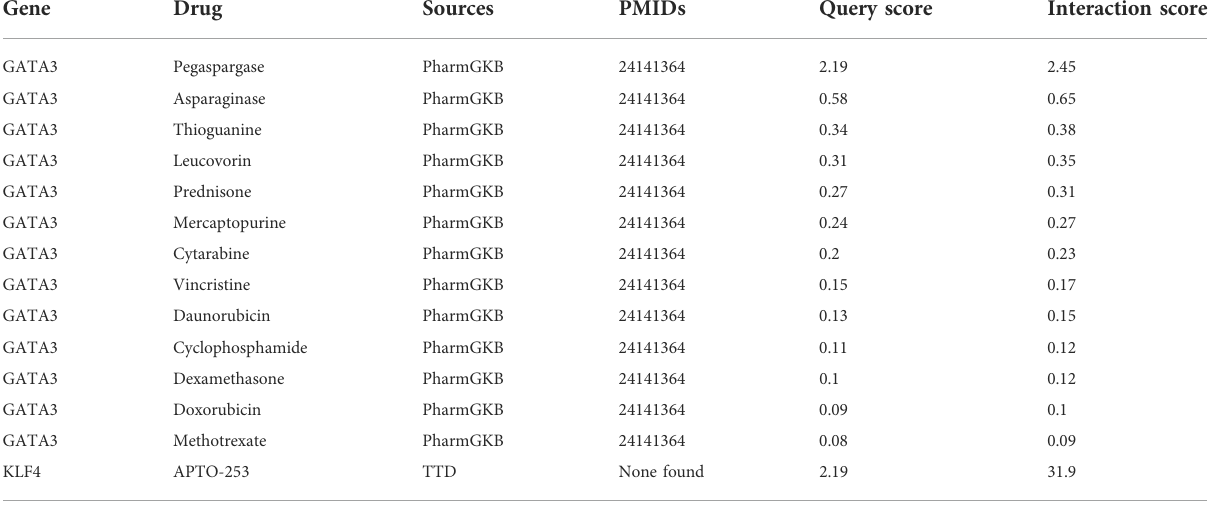
TABLE 1 Potential therapeutic drugs corresponding to the diagnostic biomarkers.